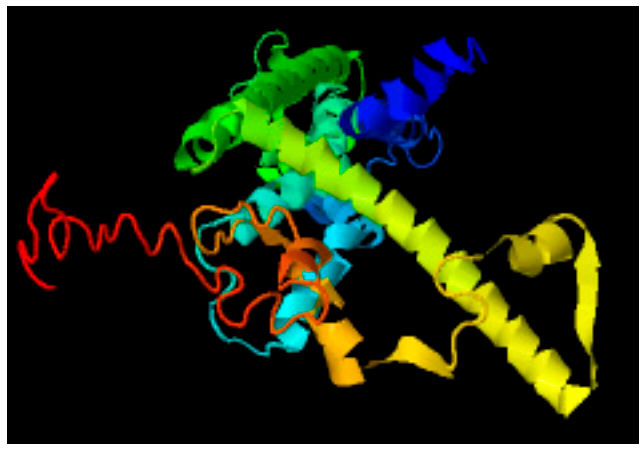
Figure 8. Best predicted model by MUSTER.